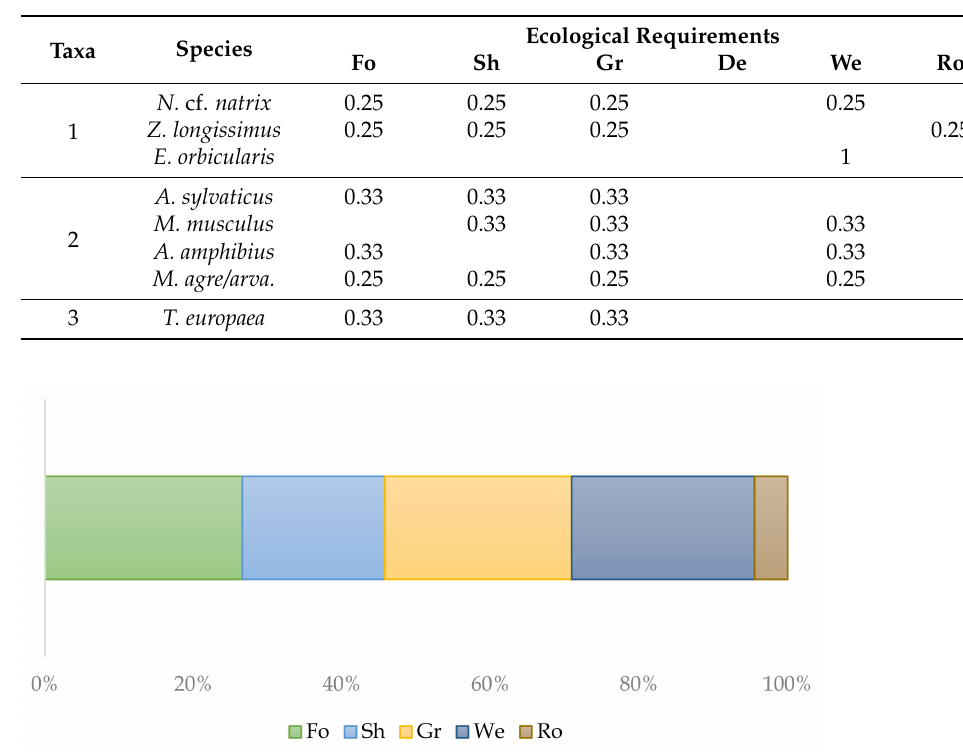
Table 7. Scores attributed to each key microvertebrate species found at Borsodiv á nka during the 2020 campaign according to its ecological requirements, used for the habitat weighting method Forest (Fo), Shrubland (Sh), Grassland (Gr), Wetland (We), and Rocky (Ro). 1. Squamata, 2. Rodentia, 3. Insectivora.